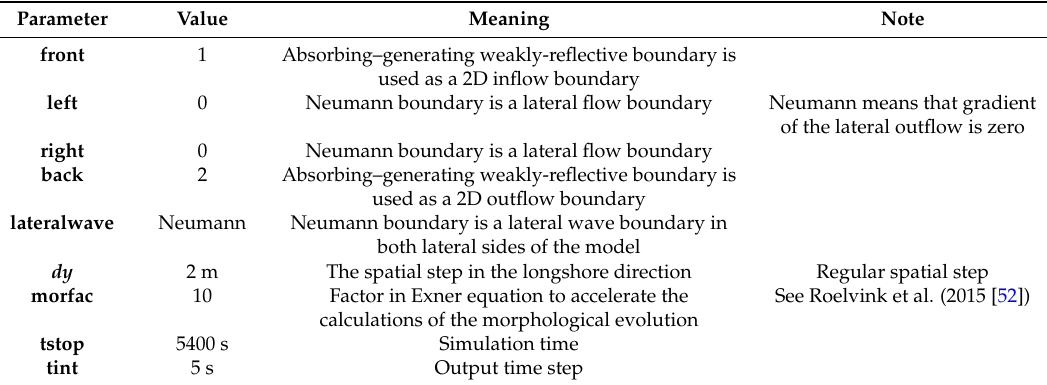
Table 2. Main parameters and boundary conditions used in the analysis of the 2D synthetic coastal area (Figure 3) using